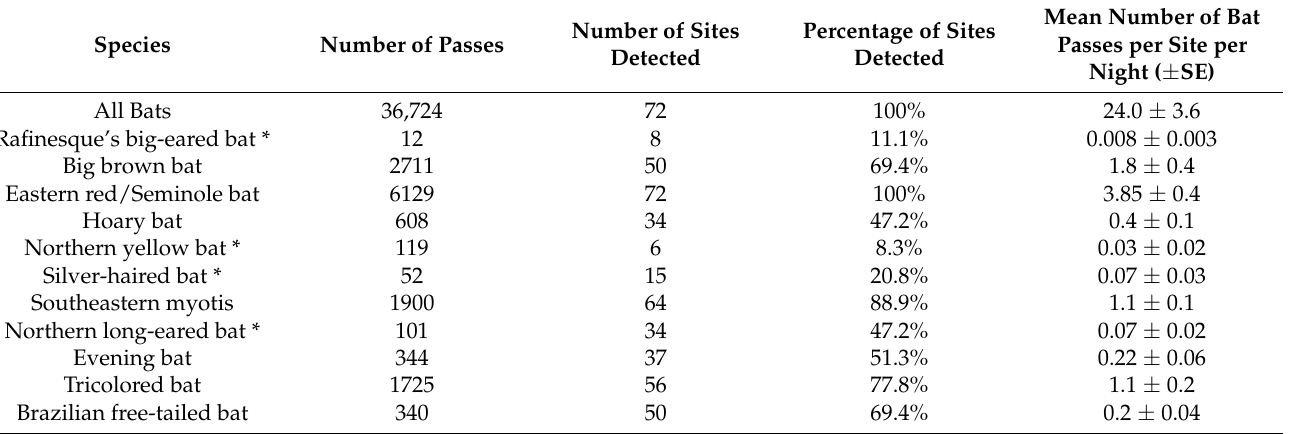
Table 3. Number of passes recorded for each species across all detector locations during winter survey efforts in 2018 and 2019. Number of detector locations where each species was recorded and the percentage of sites (n =